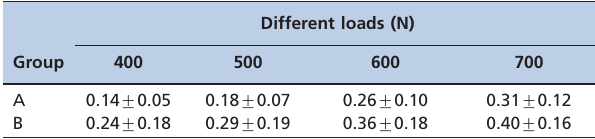
Table 1 - Different loading-lateral displacement of the posterior column inner wall in the standing position (x ¡ s mm).